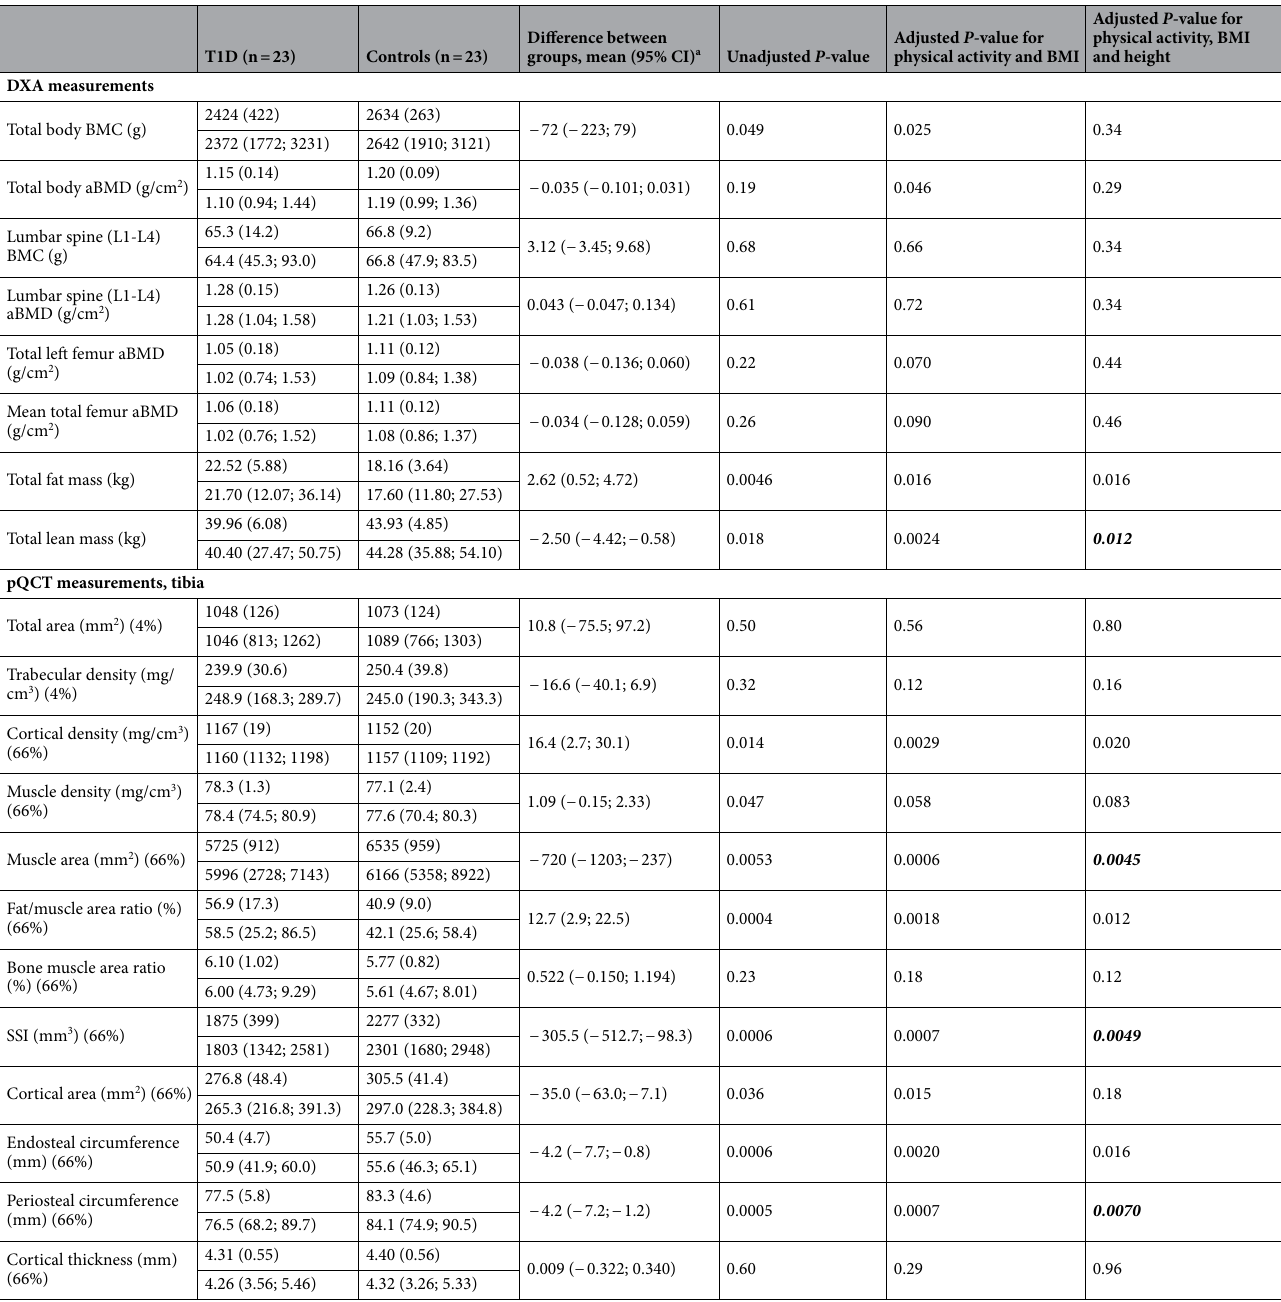
Table 2. Analyses of DXA and pQCT in subjects with T1D and matched healthy controls. For continuous variables, mean (SD)/median (minimum; maximum) are presented. Bold and italic P -values remain significant after multiple comparison using the Hochberg step-up procedure for analyses adjusted for physical activity, BMI and height. a Adjusted for physical activity, BMI and